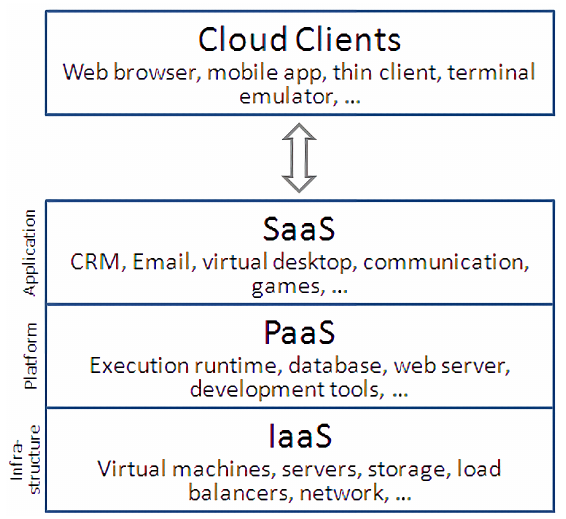
Figure 3. Cloud computing business model [12].